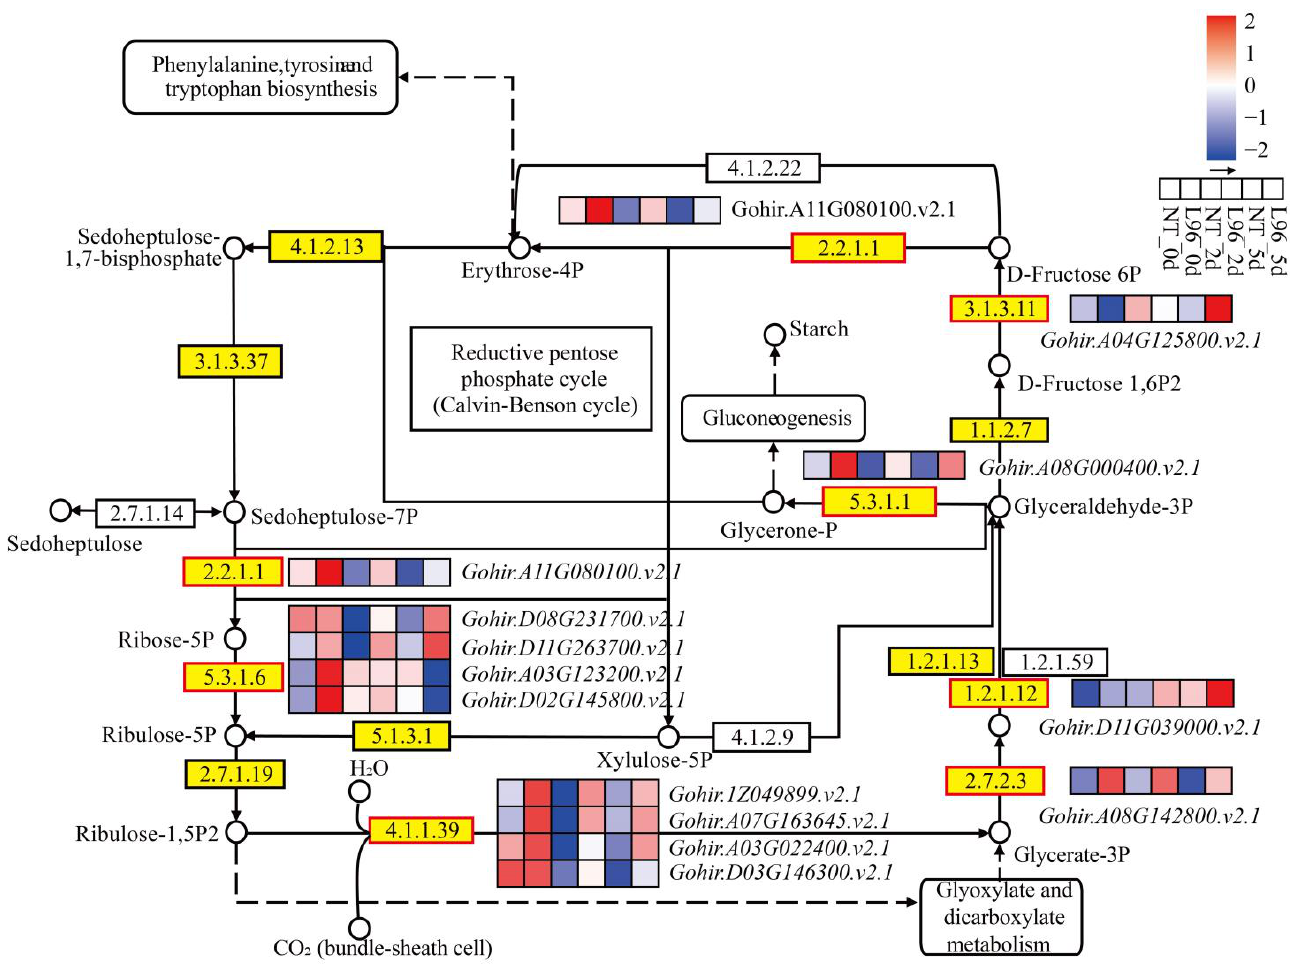
Figure 6. Carbon fixation in photosynthetic organisms activated by L96 and NT under salt stress. Heatmap shows FPKM values in each treatment, normalized using z-score.